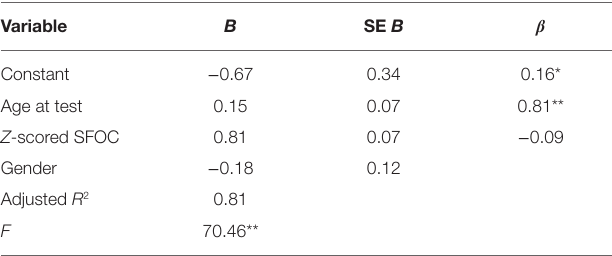
TABLE 3 | Summary of linear regression analysis for three variables (child’s age at test, gender, z -scored SFOC) predicting Spontaneous Focus on